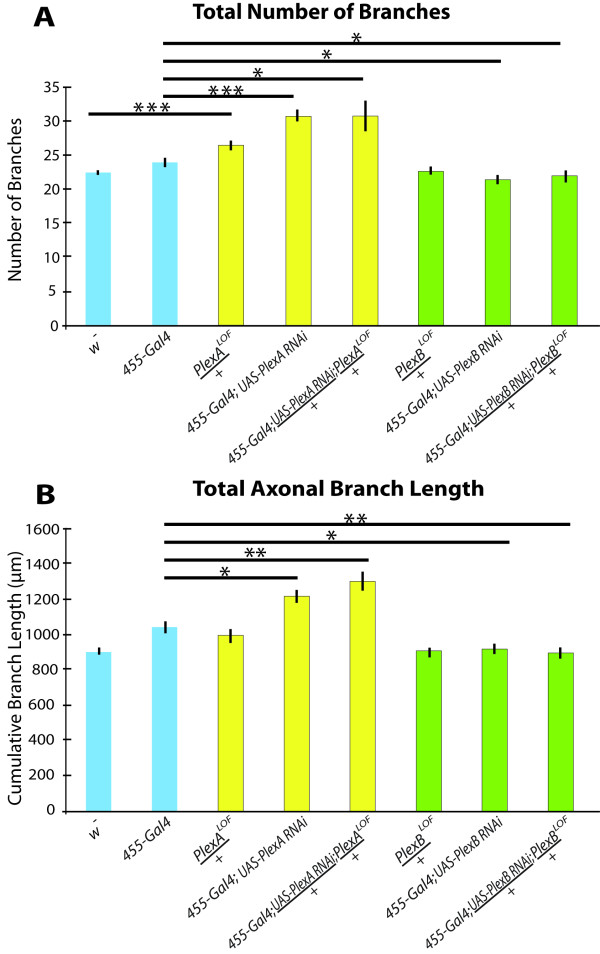
Reducing PlexinA in axons produces opposite effects from reducing PlexinB. A, The pSc axonal arbors in PlexinA mutants have significantly more branches compared to controls. RNAi of PlexinB in pSc neurons using the 455-Gal4 driver significantly reduced the number of branches compared to 455-Gal4 controls. B, PlexinA RNAi in pSc neurons increased the total axonal arbor size, and PlexinB RNAi in pSc neurons decreased the arbor size. Combining the RNAi in pSc neurons with the heterozygous mutant enhanced the RNAi phenotype compared to 455-Gal4 controls, but was not significantly different from RNAi in pSc neurons alone. 1 asterisk indicates statistically significant differences with p values less than 0.05, 2 asterisks represent p values less than 0.01, and 3 asterisks represent p values less than 0.001. Measurements in all PlexinA mutants are significantly greater than measurements in all PlexinB mutants in both graphs, and are not indicated for clarity.